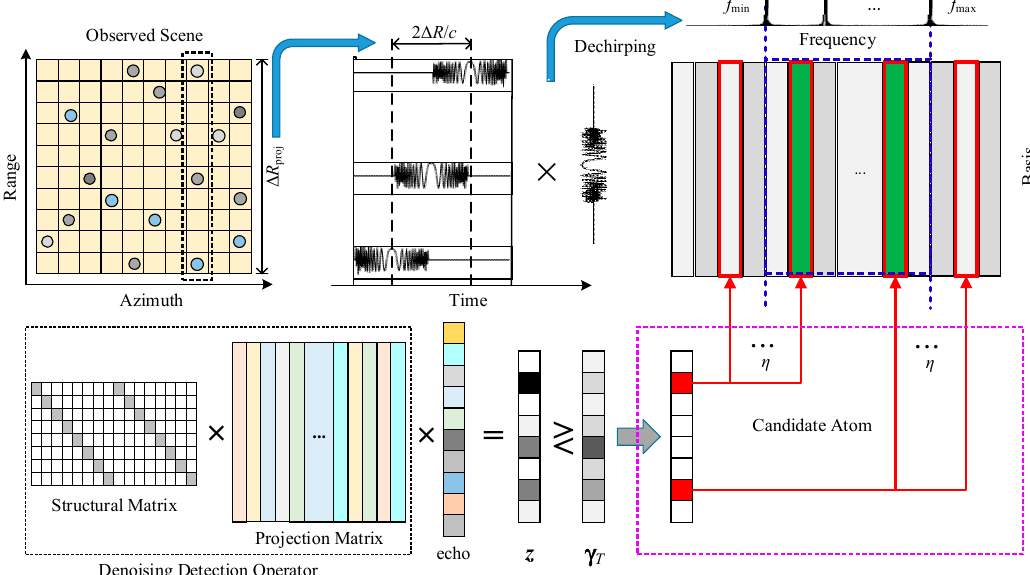
Figure 4. The diagram of double subspace extraction.